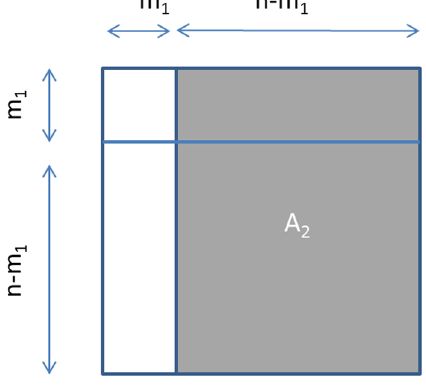
FIG. 14. Matrix A ð 2 Þ and its submatrix A 2